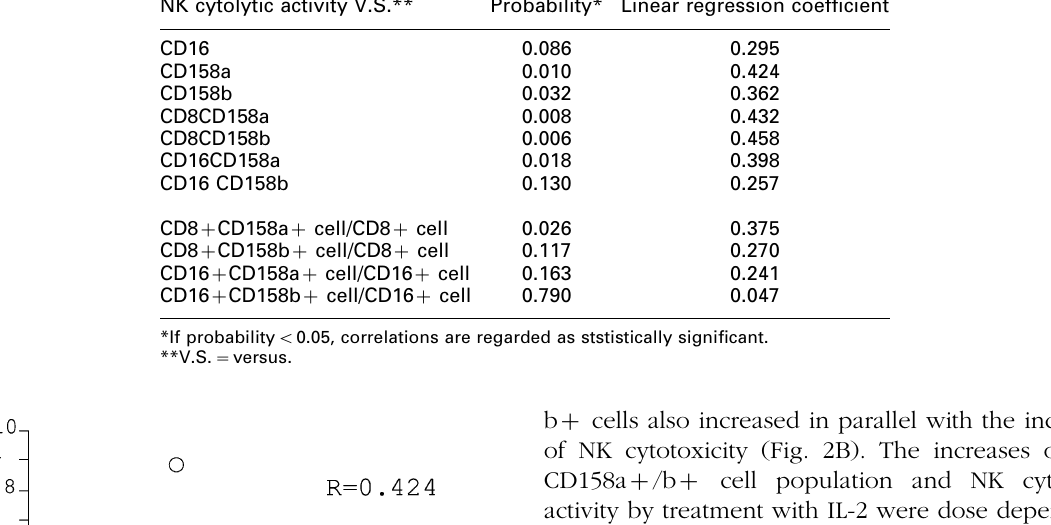
Natural killer on peripheral lymphocytes in Table 1. Correlation of NK cytolytic activity with several cell surface antigens NK cytolytic activity V.S.** Probability* Linear regression coefficient